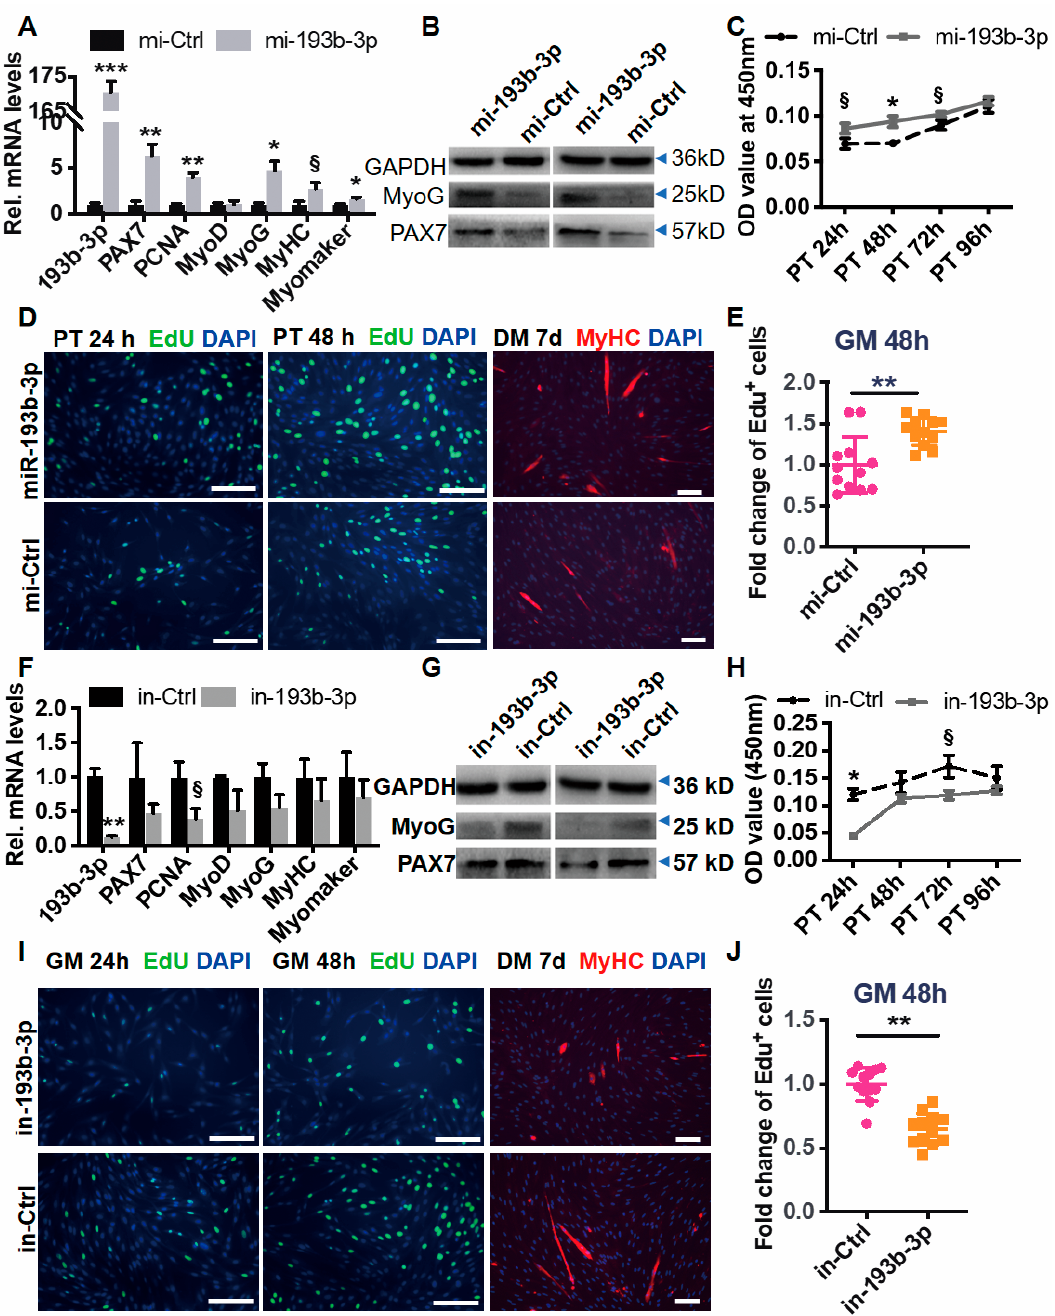
Figure 2. miR-193b-3p promotes the proliferation and differentiation of goat skeletal muscle satellite cells (MuSCs). ( A ) Ectopic miR-193b-3p elevates the mRNA abundance of myogenic genes. The cultured goat MuSCs were transfected with miR-193b-3p mimic or control (mi-193b-3p or mi-Ctrl, 50 nM). The RNA levels are quantified via RT-qPCR and calculated using the 2 − ∆∆ Ct , with β -actin (ACTB) as an internal control and values of the mi-Ctrl set to 1. ( B ) miR-193b-3p upregulates the proteins of PAX7 and MyoG. Western blotting (WB) assay was typically performed to detect MyoG and PAX7 protein in MuSCs treated with miR-193b-3p or mi-Ctrl. GAPDH works as a loading control. ( C ) miR-193b-3p promotes cell proliferation measured using Cell-Counting Kit-8 (CCK-8). ( D , E ) miR-193b-3p increases EdU + cells and myotube formation. Left panel, Representative immunofluorescence images of EdU and MyHC staining cells after transfected mi-193b-3p or mi-Ctrl (50 nM). Cells are cultured in GM consisting of 10 µ M EdU, stained with anti-DAPI (blue) and anti-MyHC (red). Scale bar = 100 µ m. Right panel, EdU-stained cells (ratio of EdU + myoblasts to all) are evaluated using randomly